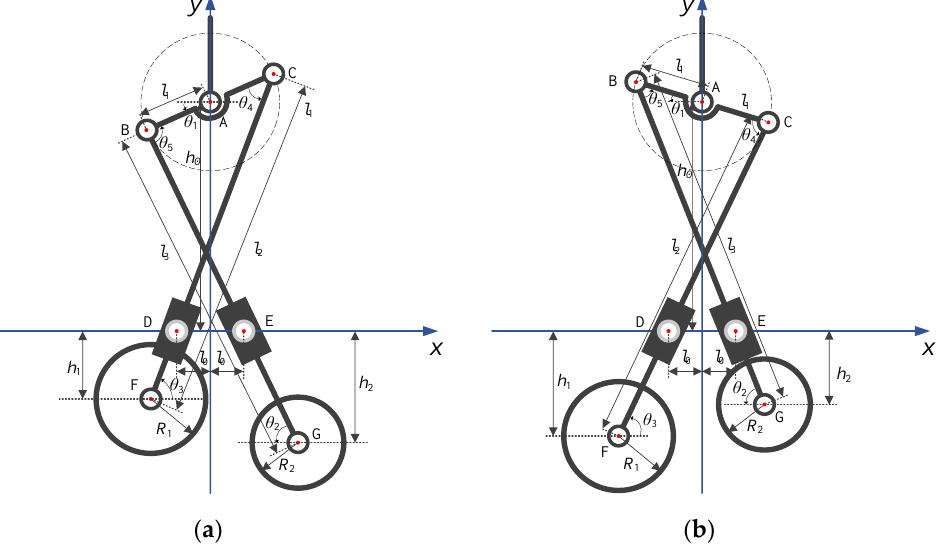
Figure 5. Schematic diagram of compaction segments conforming arbitrary surfaces with different longitudinal displacements, illustrating the lifting angles θ 1 to θ 5 , link lengths l 0 , l 1 , l 2 , and l 3 , longi- tudinal displacement h 1 and h 2 and other geometric information; ( a ) and ( b ) show the compacting process corresponding to Figure 4d,c,